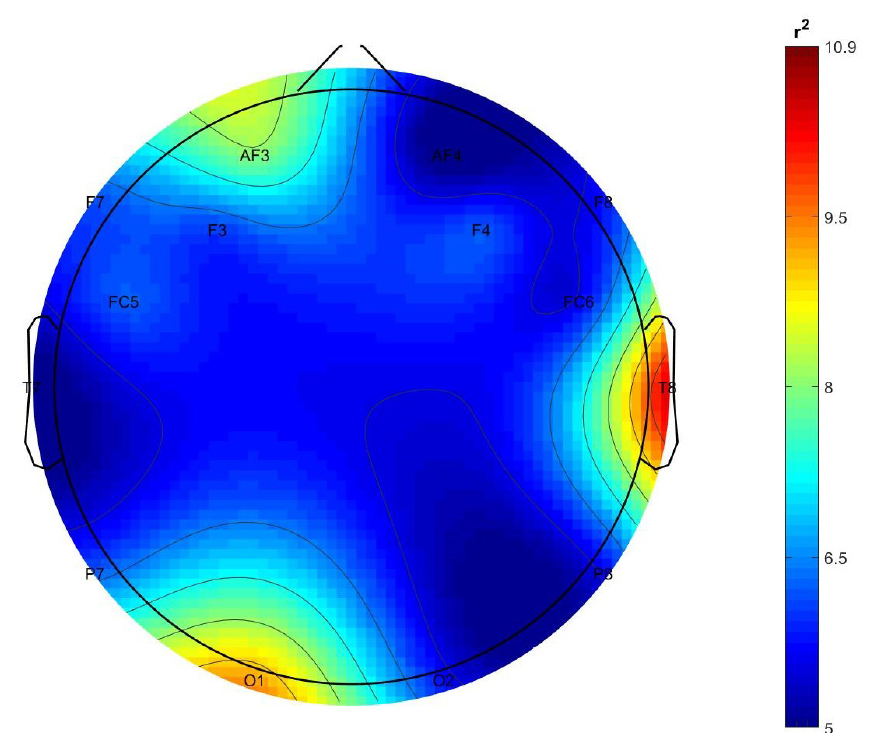
Figure 2. Topographic distribution of r 2 coefficients (stimulation vs non-stimulation discriminative power) in the non-stimulated participants.